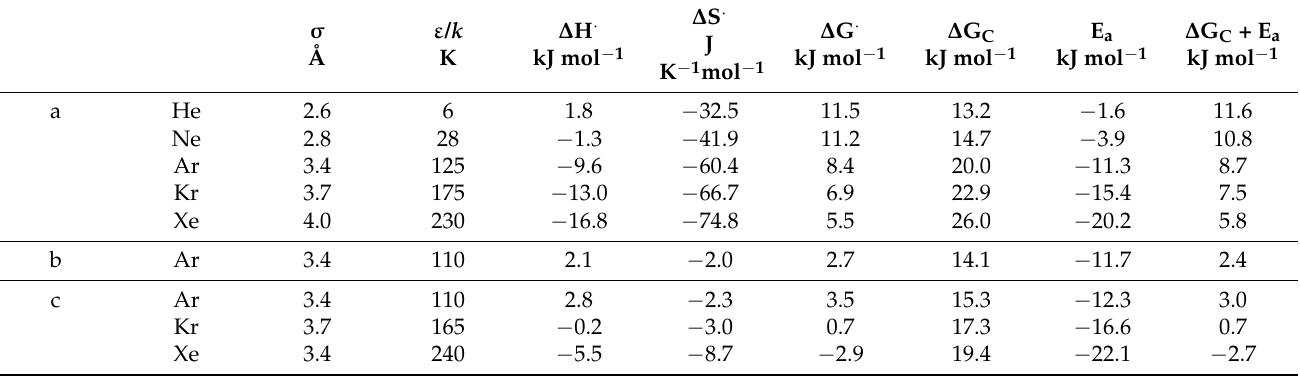
Table 1. Experimental thermodynamic data for the solvation [32–34], according to the Ben–Naim standard (i.e., the transfer from a fixed position in the gas phase to a fixed position in the liquid phase), at 25 ◦ C and 1 atm, of noble gases in water (a), CCl 4 (b), and C 6 H 6 (c); the values of the hard sphere diameter and the Lennard–Jones energy parameter come from [35,36] with small modifications; the values of ∆ G C are calculated by means of classic SPT analytical formulas [27,28]; those of E a are calculated by means of Pierotti’s analytical formula